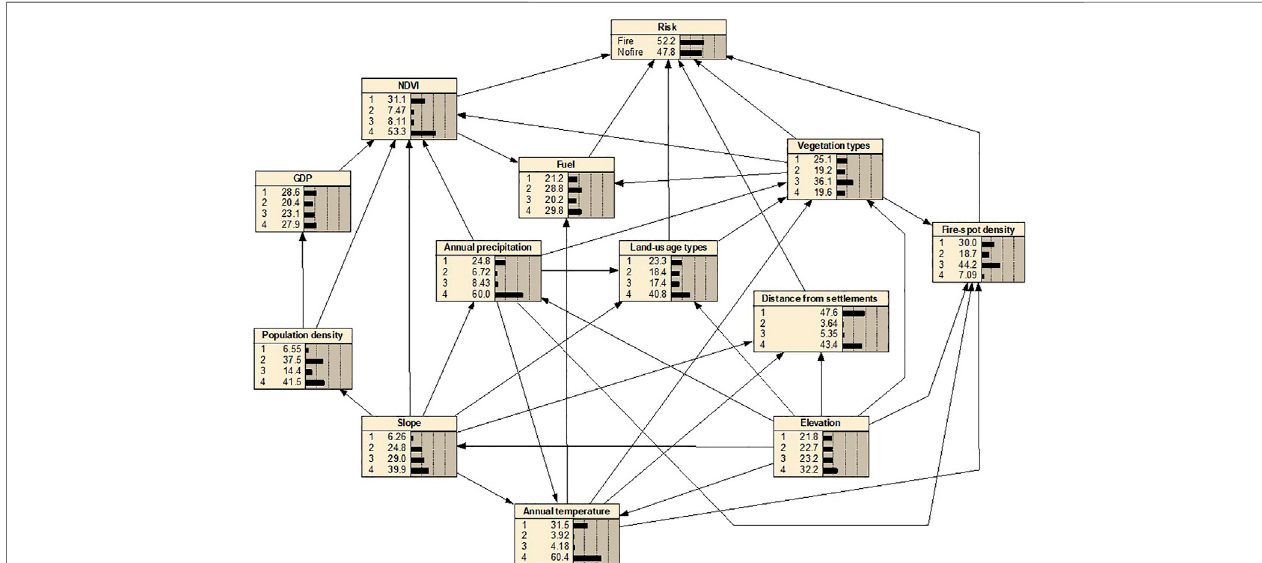
FIGURE 7 | The model framework based on